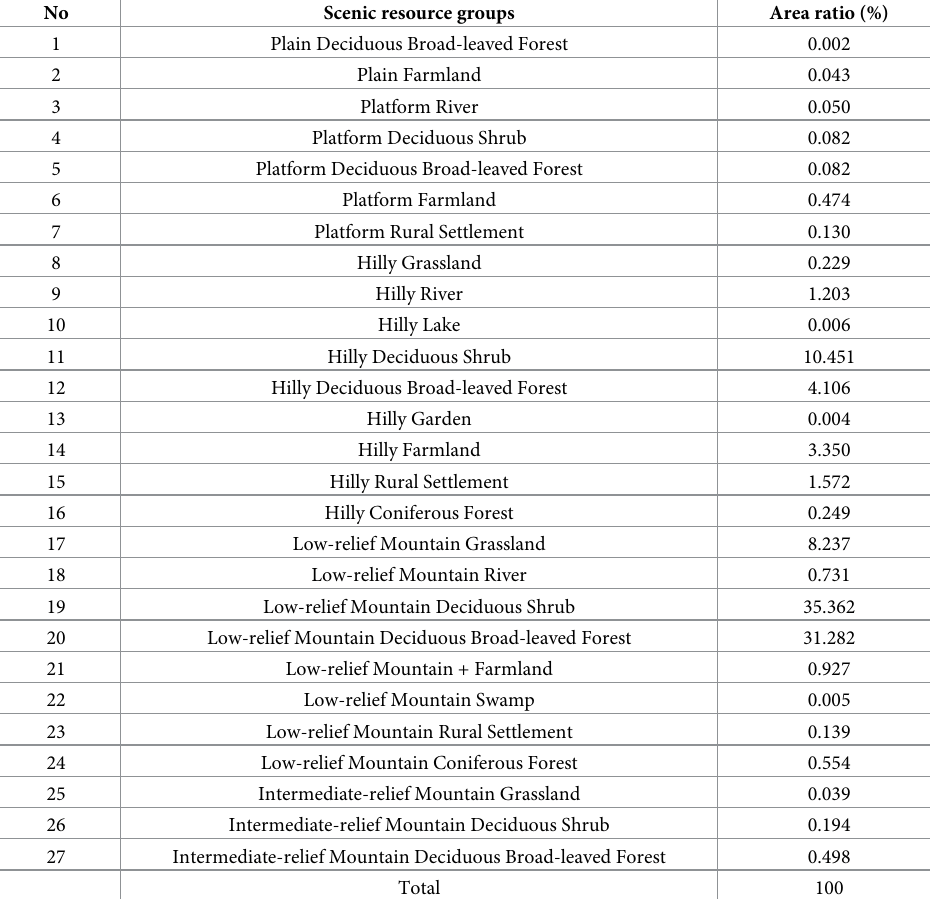
Table 4. Scenic resource groups in plain and platform areas in non-canyon/river valley